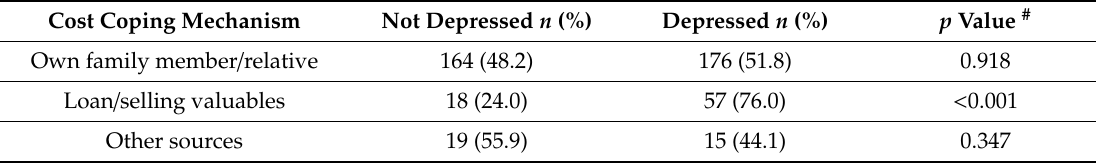
Table 5. Cost coping mechanism of the families for health care in the last month by depression status ( n =